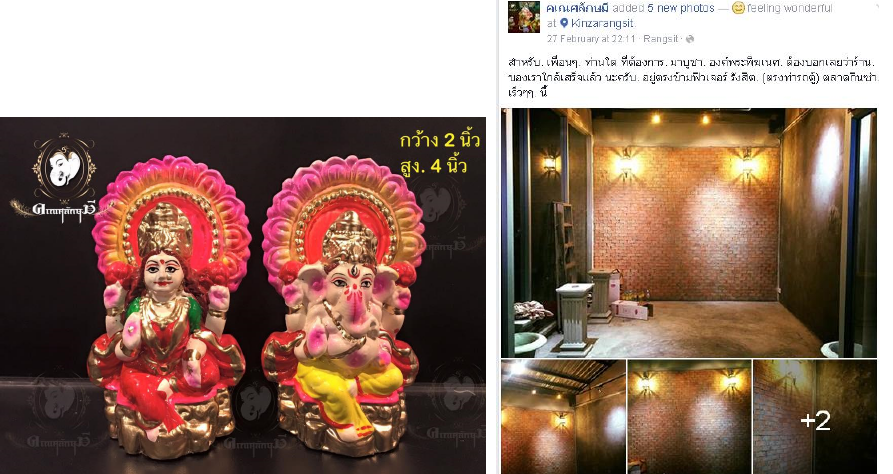
Figure 5. A pair of Laxmi and Ganesa (2-inch-wide and 4-inch-tall) was posted on GaneshLuck- shamee’s Facebook page on 20 January 2016; a new physical shop in Future Mall, Rangsit, under construction by GaneshLuckshamee, was posted on 27 February 2016. The Thai post invites visitors to the physical shop located in Rangsit area, currently under construction. Images used with permission.